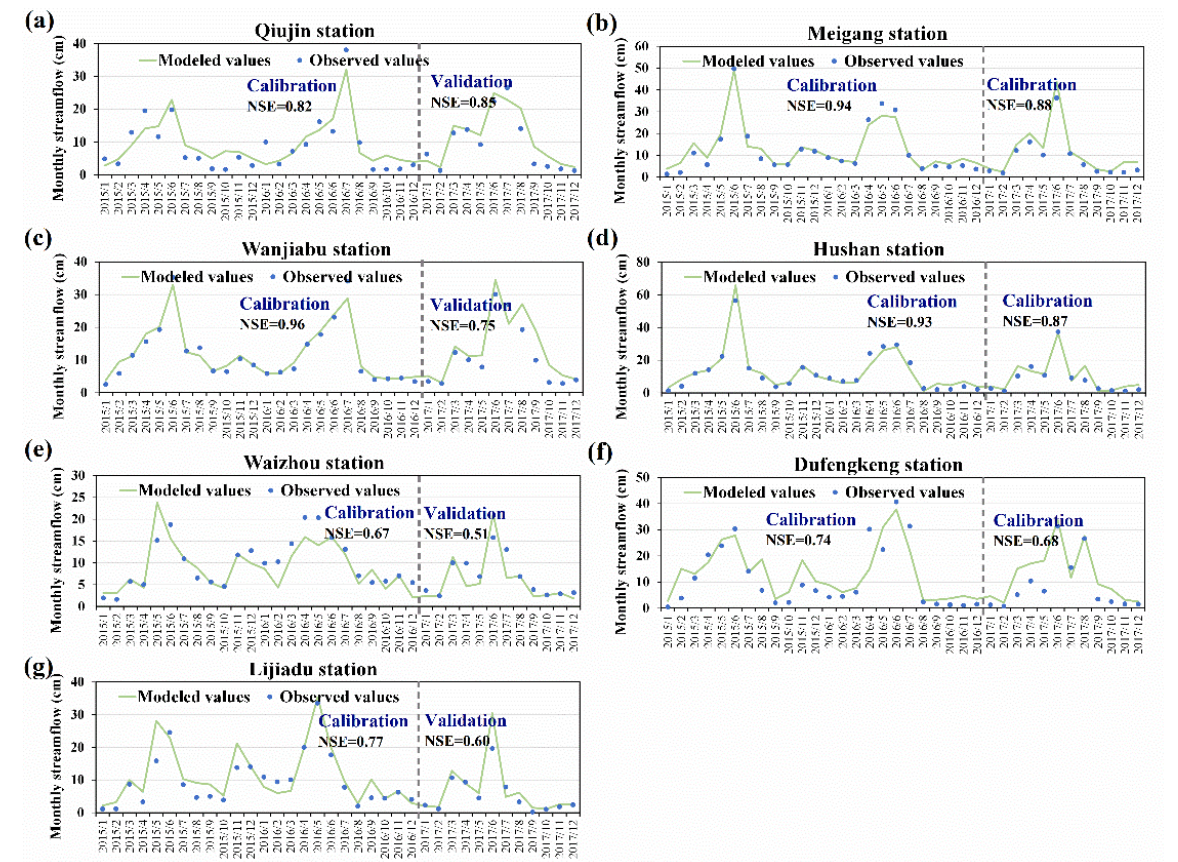
Figure 4. Modeled versus Observed values of streamflow and NSE at ( a ) Qiujing, ( b ) Meigang, ( c ) Wanjiabu, ( d ) Hushan, ( e ) Waizhou, ( f ) Dufengkeng, and ( g ) Lijiadu.